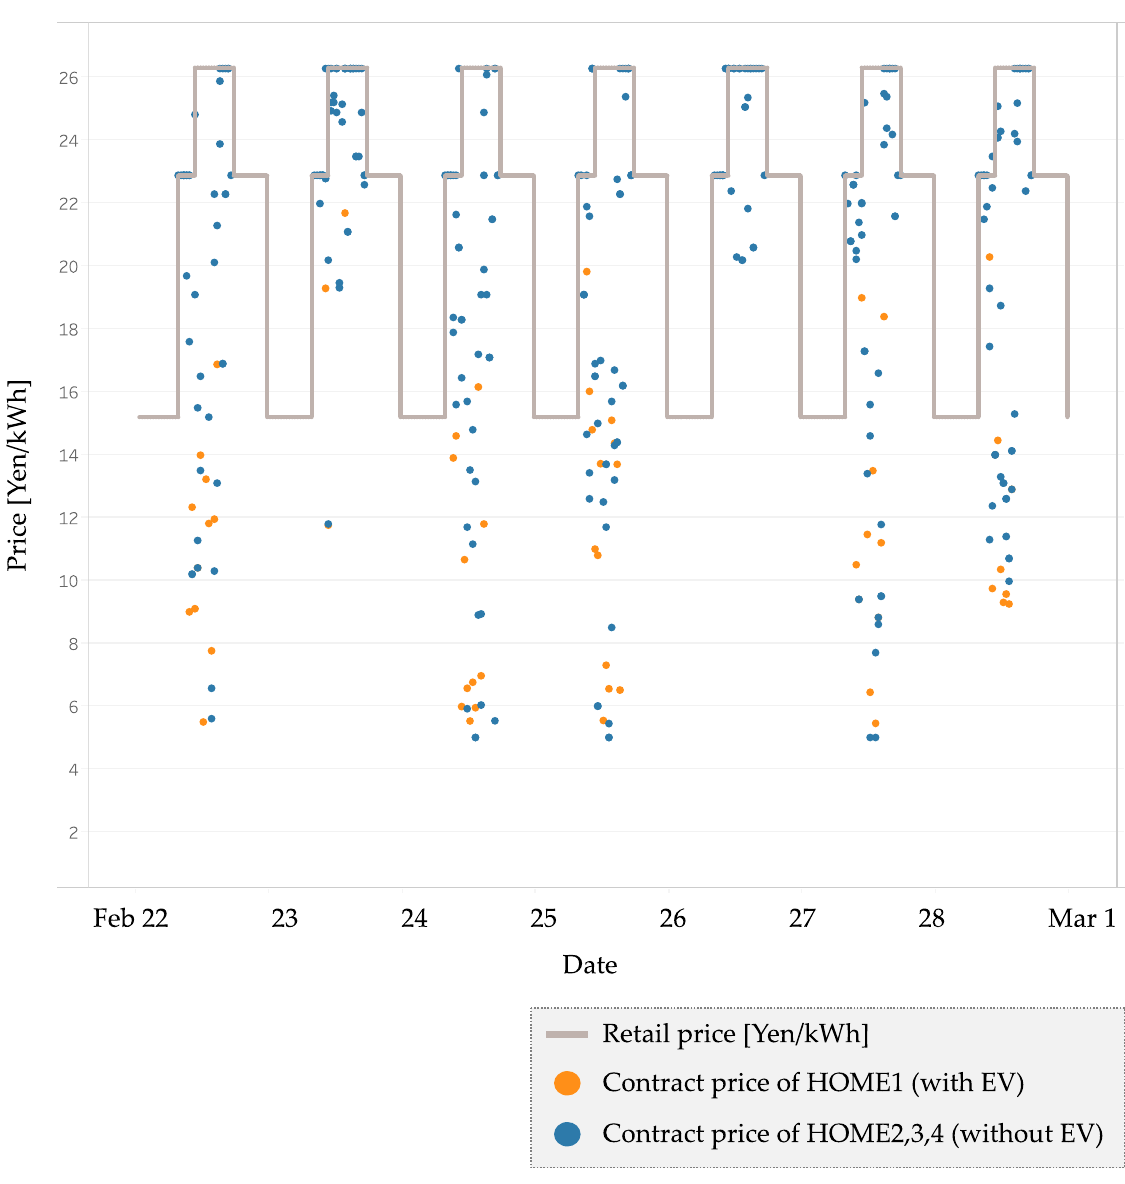
Figure 4. Contract price and retail price by user and time period.